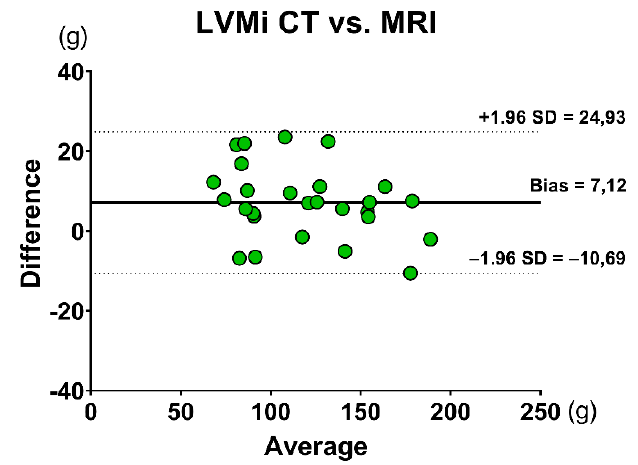
Figure 2. Bland–Altman analysis of LVMi assessment between CMR and CCT. Abbreviations: CCT: cardiac computed tomography; CMR: cardiac magnetic resonance; LVMi: left ventricular mass index.